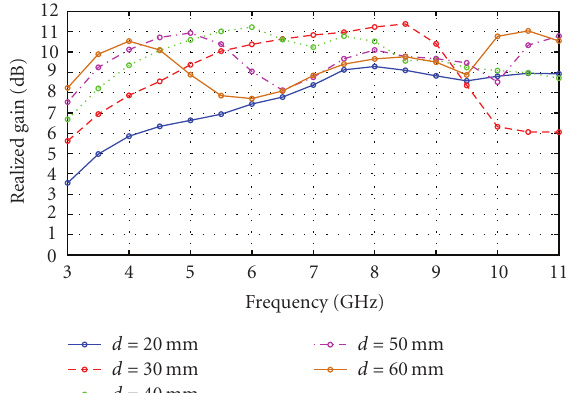
Figure 17: Simulated | S 11 | curves of the four-element UWB array at element spacing d = 28 mm compared to a single antenna